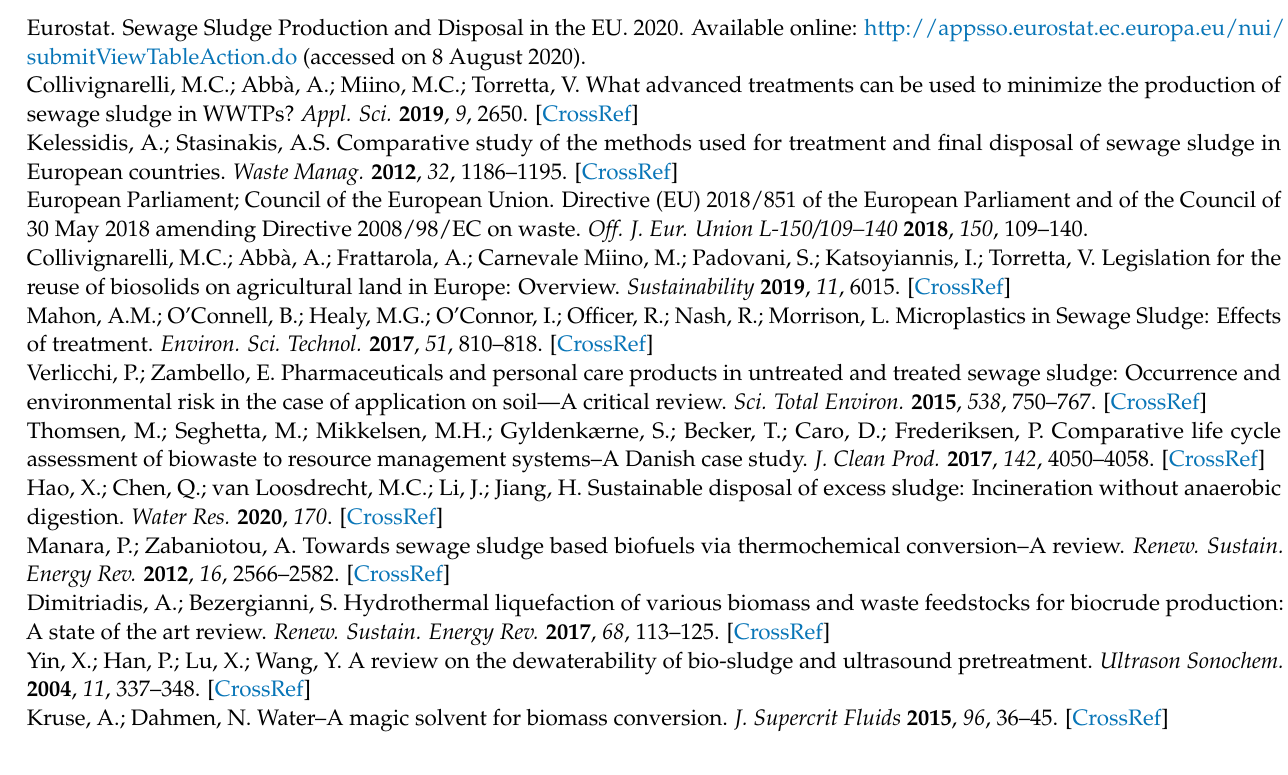
Figure S3: TOC and TNb concentration and cumulative C and N removal from MSS, Table S1: Content of amino acids in sewage sludge and pre-treated solids., Table S2: Concentration of fatty acids in biocrude samples., Table S3: Concentration of representative compounds in biocrude